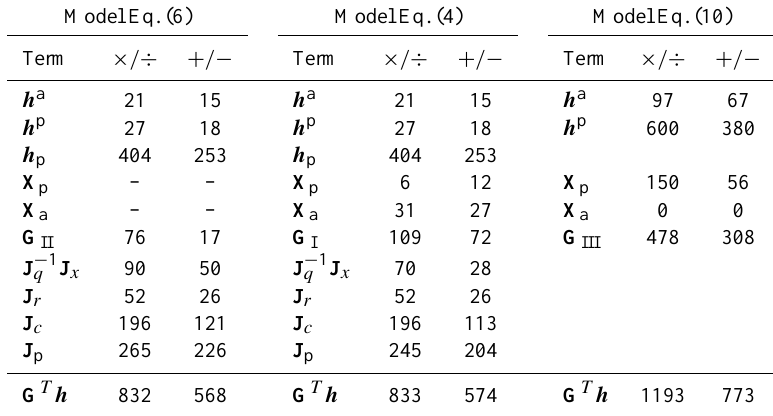
Figure 4. Formulation of the Jacobian matrix using Method II. Table 3. Computational effort for solving the inverse dynamic problem. Model Eq. (6) Model Eq. (4) Model Eq.